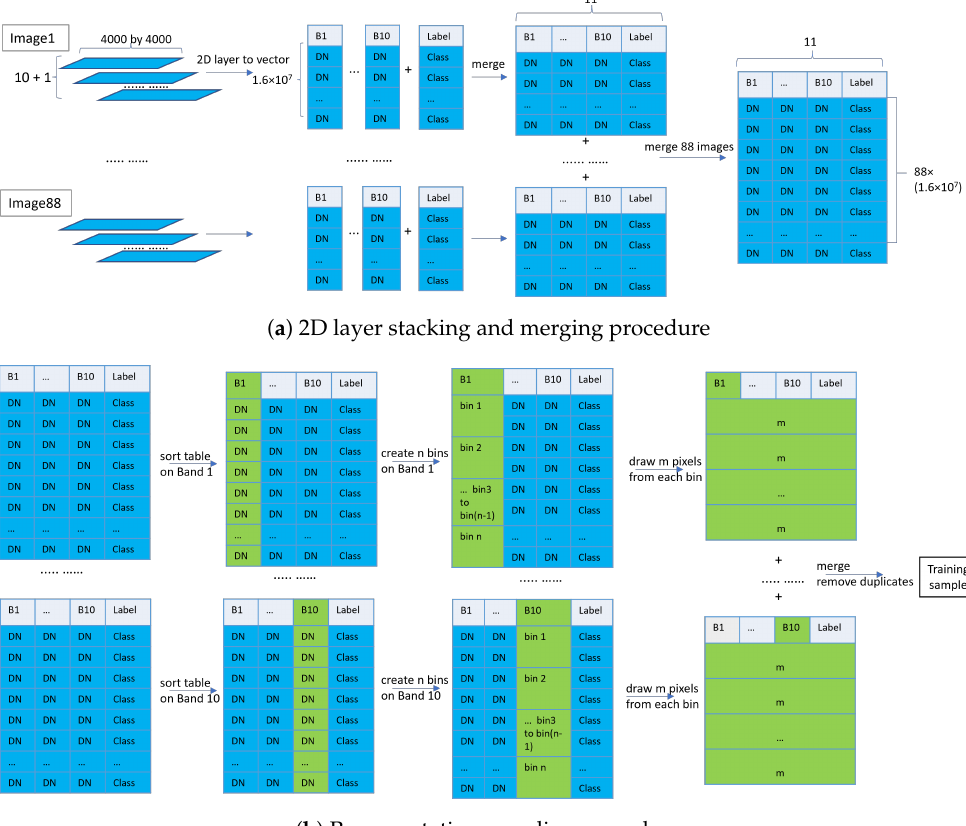
Figure 4. Flow chart illustrating the image stacking and representative sampling procedures. In the stacking and merging procedure ( a ), the 10 wavelength bands as well as the label mask for each of the 88 images are stacked as an image table. Then, the 88 image tables are merged into one image pool table. The B1–B10 and Label in the headers represent the spectral band number and the pixels class labels. DN in tables represent the digital value. In the representative sampling procedure ( b ), the image pool table is sorted on a certain column (in green), then n bins are selected from the sorted column and m pixels are drawn from each bin. A final training sample is generated after repeating this process over all